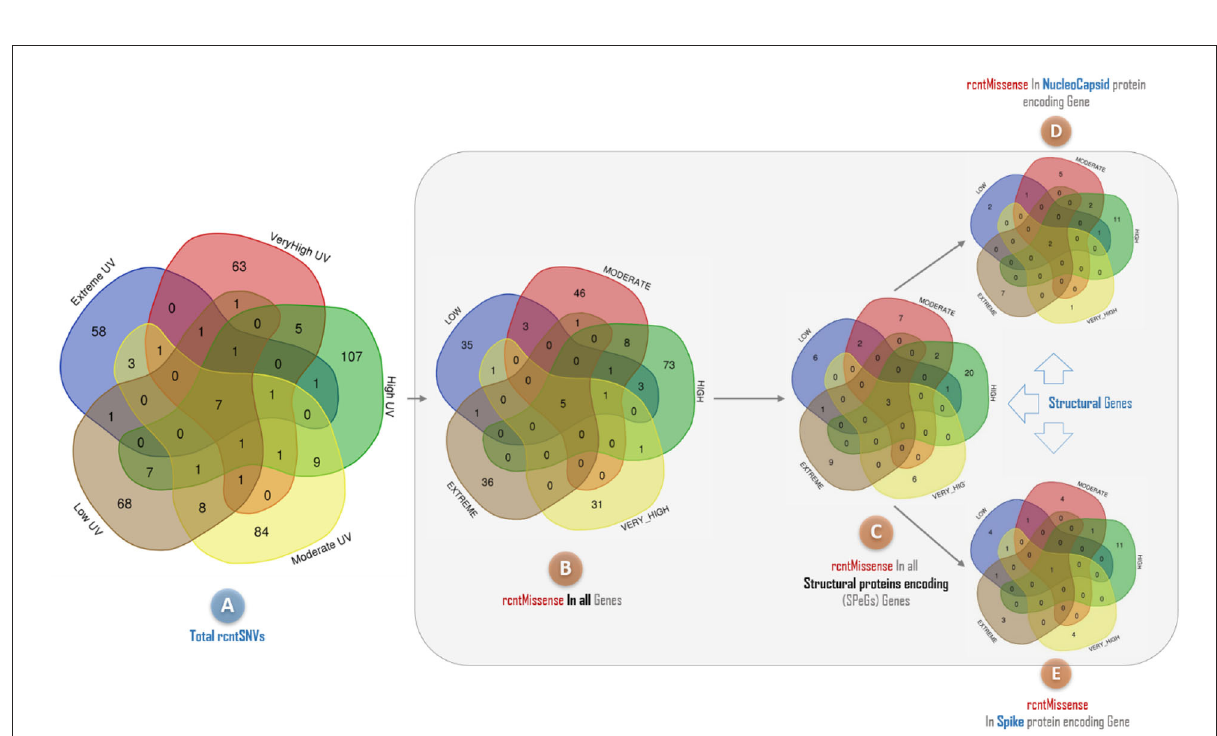
FIGURE6 A Venn diagram depicting the overlap of recurrent single nucleotide variants (rcntSNVs) found across different SARS-CoV-2 populations from five WHO’s defined UVindex country categories. The comparison based on total identified rcntSNVs across all 2,500 SARS-CoV-2 genomes from UVindex categories; Extreme (blue), Very_High (red), High (green), Moderate (yellow), and Low (brown) revealed a total of seven commonly shared variants (A) . The complete description of all UVindex categories is presented in the method section. Upon detailed functional annotation, all seven commonly shared rcntSNVs are found with five shared missense functional effects (rcntMissense-effects) on gene’s functions (B) , of which three shared rcntMissense-effects are revealed in structural protein-encoding genes (C) , comprising two in nucleocapsid (D) and one in spike (E) . In all Venn diagrams, the UVindex-specific rcntSNVs/Missense-effects (CaSp-rcntSNVs/Effs) counts are given near the outer edges, whereas the shared rcntSNVs/effects are represented in the dark brown core middle of each